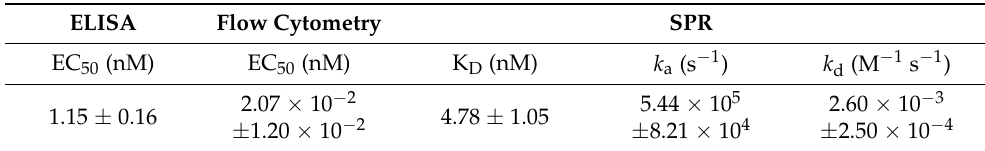
Table 1. Estimated EC 50 values and affinity constants of anti-DLL1 Dl1-72 mAb towards DLL1. Data are mean value ± SD of three independent ELISA and flow cytometry assays and three replicates from the SPR assays. ELISA Flow Cytometry